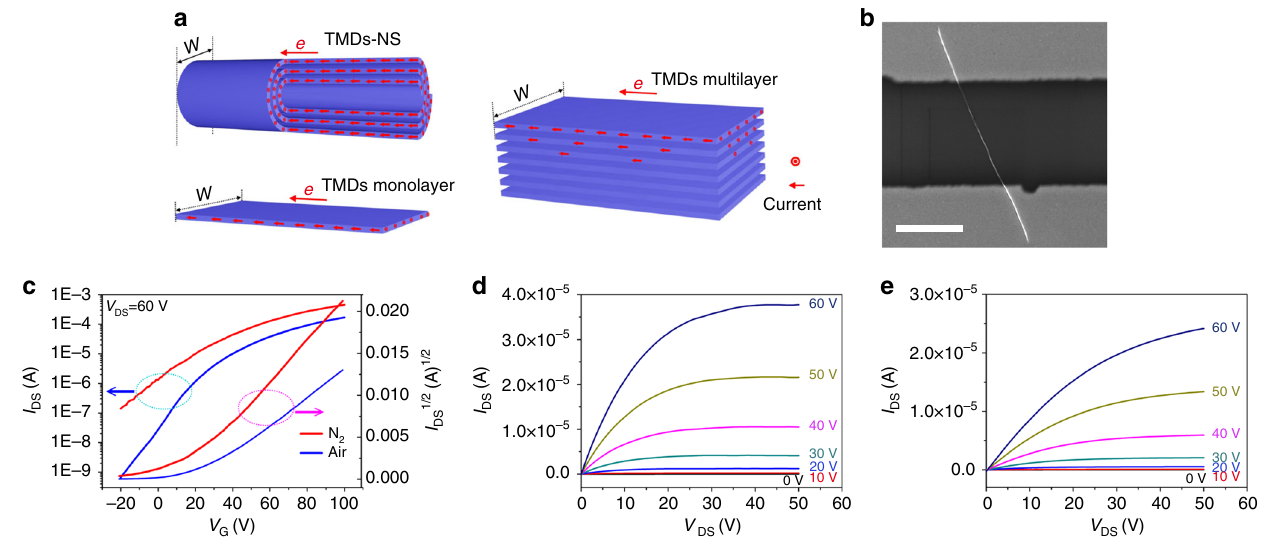
Fig. 4 Electrical characteristics of MoS 2 -NSs (nanoscrolls). a Schematic representations of current conduction in transition metal dichalcogenide (TMD)- nanoscrolls (NSs), TMDs monolayer, and TMDs multilayer under bias. The W represents the conduction channel width. The NSs made from the below TMDs monolayer have a much shorter W . For TMDs multilayer, the current only passes through the outermost shell layers. b SEM image of a typical MoS 2 -NS FET (scale bar, 10 μ m). c Transfer characteristics of MoS 2 -NS tested in N 2 (red) and air (blue). d Output characteristics of MoS 2 -NS tested in N 2 . e Output characteristics of MoS 2 -NS tested in